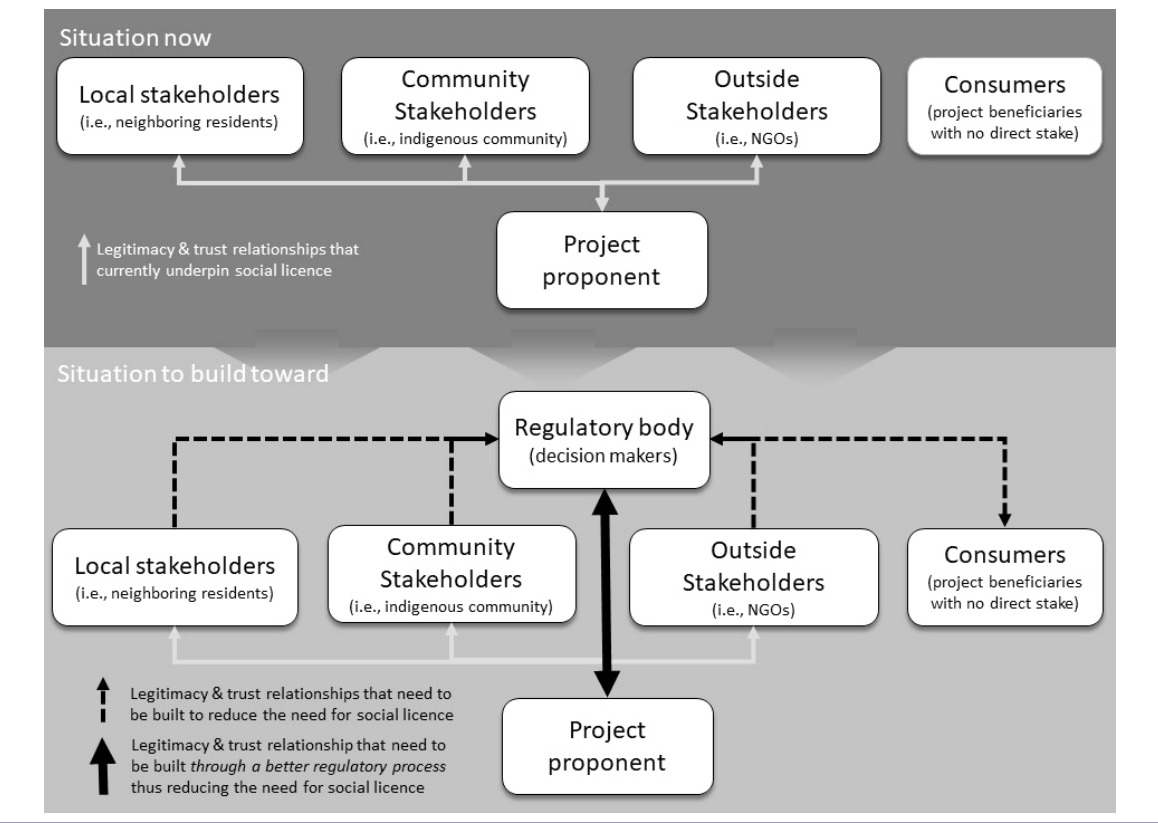
Fig. 1 . Conceptual representation of the trust and legitimacy relationships of different groups of actors (indicated in the white boxes) in the context of a natural resource development project. The top section represents the current situation and the bottom section represents the situation to build toward in which the need for social licence is replaced. In both the top and bottom sections the light grey arrows represent the legitimacy and trust relationships that currently underpin social licence. In the bottom section of the figure, the dashed arrows indicate the trust and legitimacy relationships that should be strengthened to reduce the need for social licence and the solid arrow represents the trust and legitimacy relationships that need to be built through a better regulatory